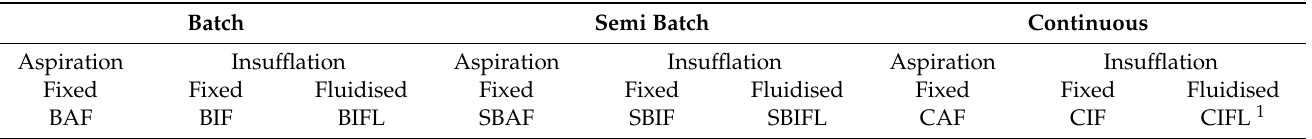
Table 5. The morphological chart of the designs.